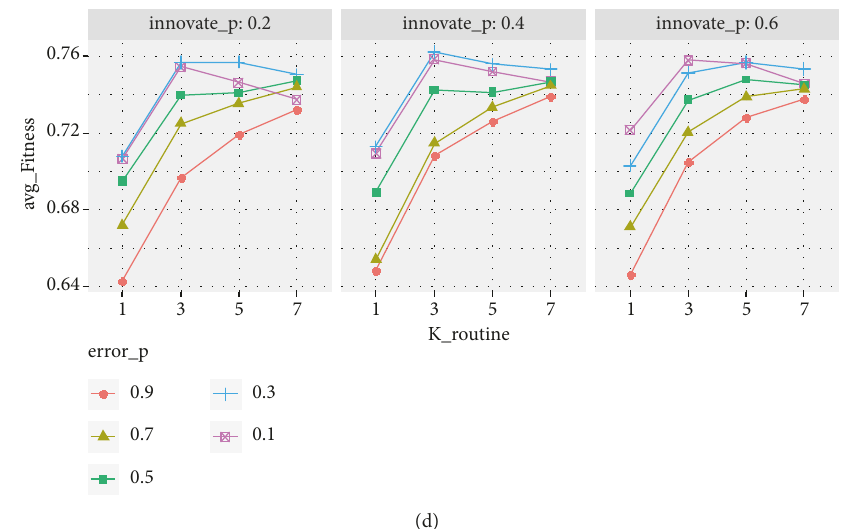
Figure 7: Simulation results with template-duplicating errors and units’ innovative activities (Scenario II: random p = 0.5 and unit AC = 2): (a) steadyTime values; (b) replicate num values; (c) innovate num values; (d) avg Fitness